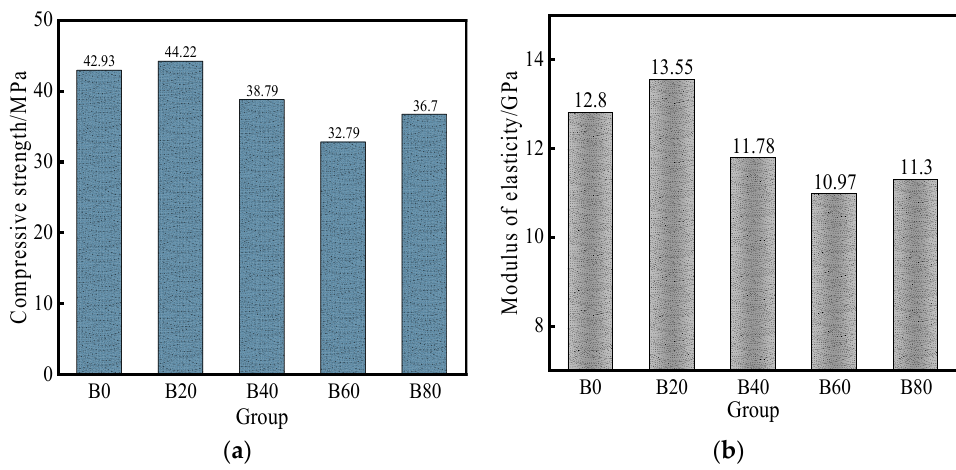
Figure 7. Compressive strength and elastic modulus of mortar for each replacement: ( a ) compressive strength; ( b ) elastic modulus.